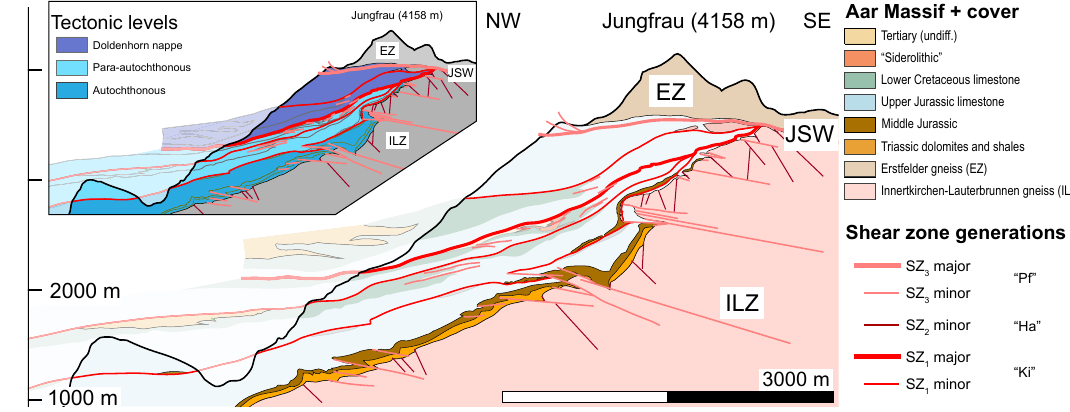
Figure 11. Simplified structural profile across the NW rim of the Aar Massif (profile trace indicated in Fig. 2).